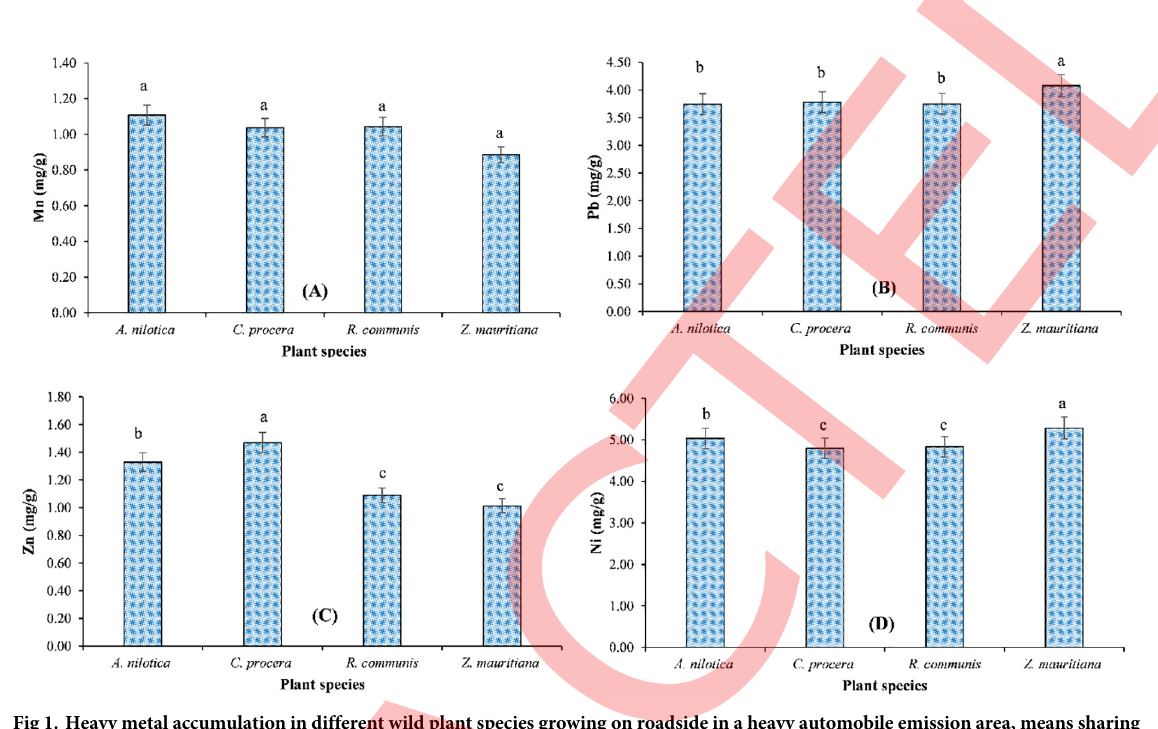
Fig 1. Heavy metal accumulation in different wild plant species growing on roadside in a heavy automobile emission area, means sharing same letters are statistically non-significant (p > 0.05).